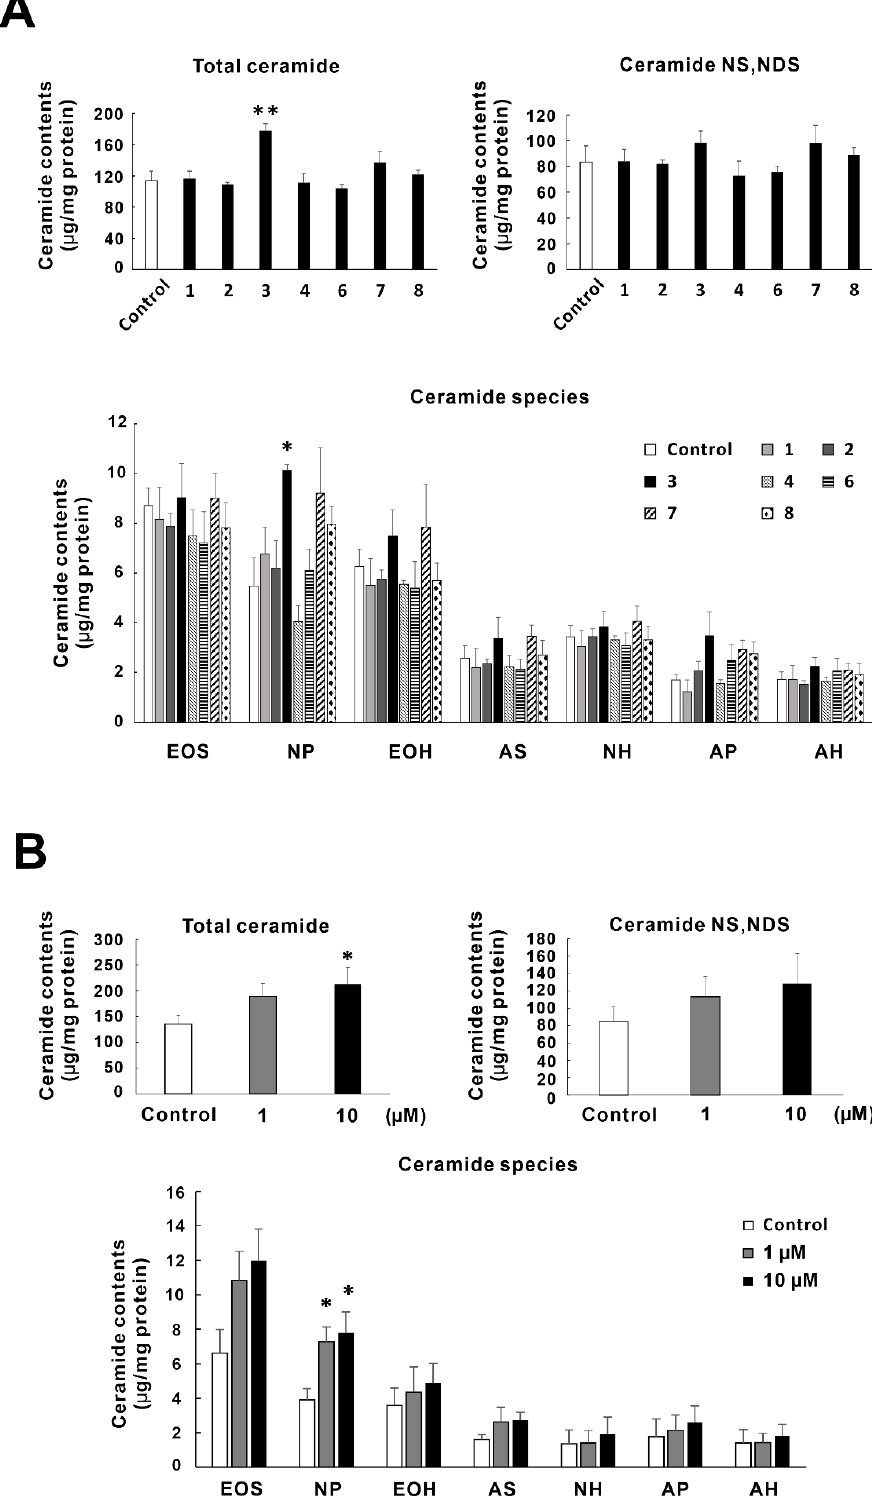
Figure 3. Effects of TSE and tomato seed saponins ( 1 – 4 , 6 – 8 ) on TEWL in RHEK models. RHEK models were treated for 5 days in culture with 10 µM of tomato seed saponins ( A ) or 1 and 10 µM of lycoperoside H ( B ). The extraction of lipids from the SC of the RHEK model and high-performance thin-layer chromatography (HPTLC) analysis were performed as described in the Materials and Methods section. Data are expressed as mean ± SE ( n = 4). * p < 0.05, ** p < 0.01 vs. control.